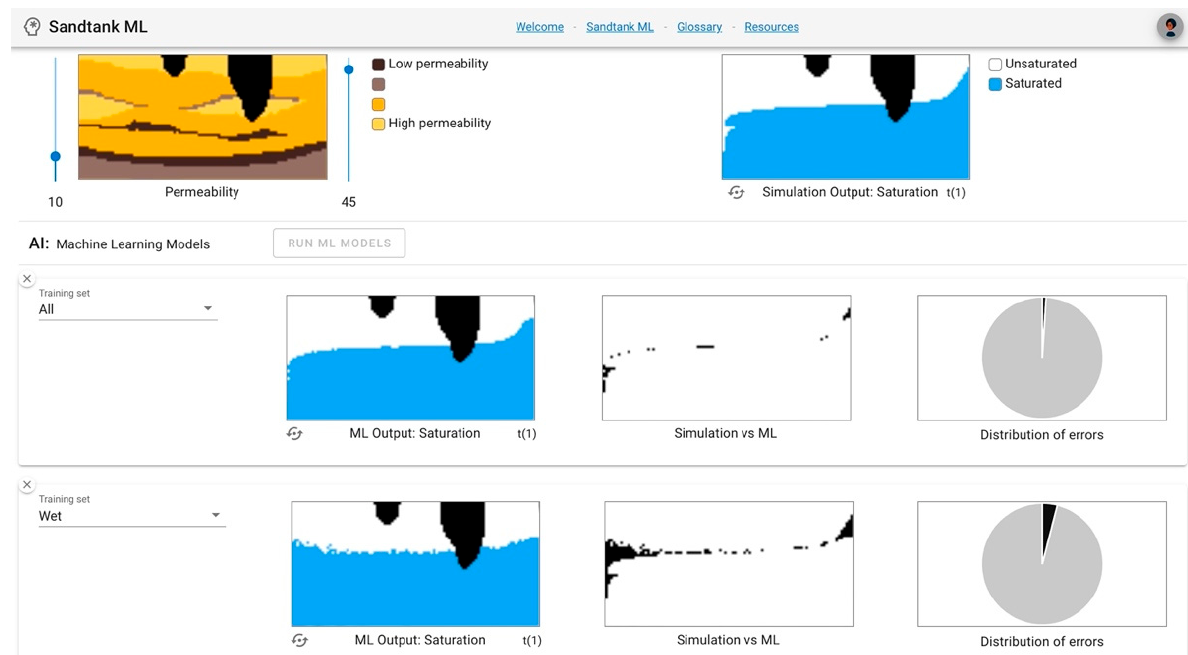
Figure 12. Sandtank-ML display for user example 2 showing the boundary condition inputs, saturation simulation output, and the associated ML saturation outputs using all and wet training datasets.